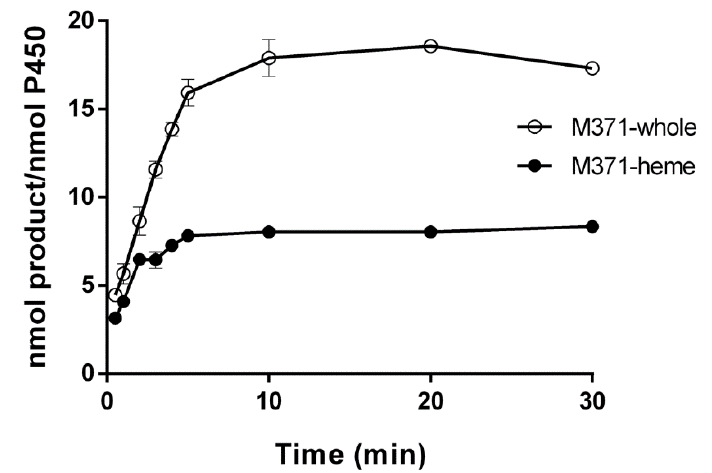
Figure 5. Total turnover numbers of atorvastatin 4-hydroxylation by CYP102A1 supported by H 2 O 2 . The reaction mixtures included atorvastatin substrate at concentration of 200 µ M and 0.20 µ M of whole M371 ( ○ ) or heme-domain in 100 mM of a potassium phosphate buffer (pH 7.4) ( • ). We added 10 mM H 2 O 2 to initiate the reaction and the reaction mixtures were incubated for 30 s, 1, 2, 3, 4, 5, 10, 20, and 30 min at 37 °C.